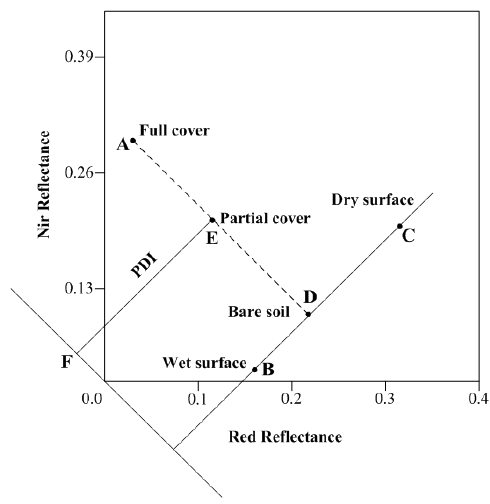
Figure 1. Near Infrared–red space and Perpendicular Drought Index [107].